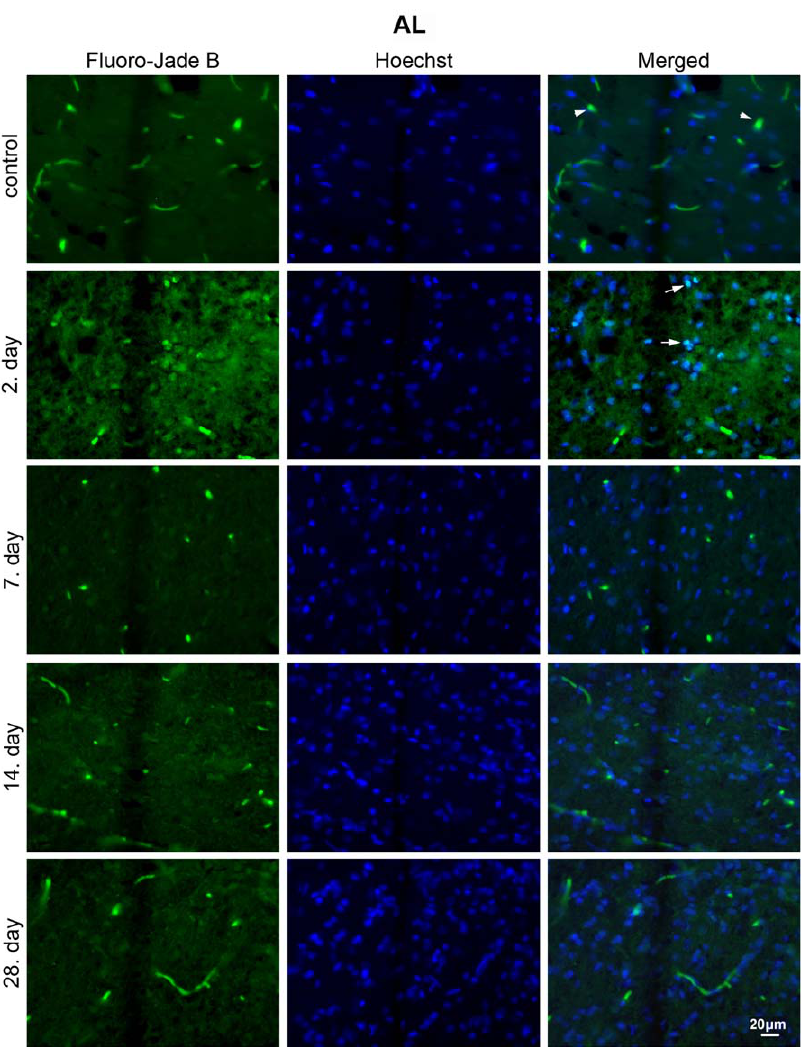
Figure 4. Neuroapoptosis is present in the perilesioned area of AL animals. Fluoro-Jade B and Hoechst staining of brain sections from AL animals 2, 7, 14, 28 days after injury. Numerous Fluoro-Jade B/Hoechst positive cells (merged) were observed in the AL group on the 2 nd day following injury (arrows); these cells were not detected at later time points. Images are representative of brain sections at the site of the lesion (n=3 animals per experimental group); c – physiological control; 2, 7, 14, 28 – days following injury; blood vessels (arrowheads); magnification 40 6